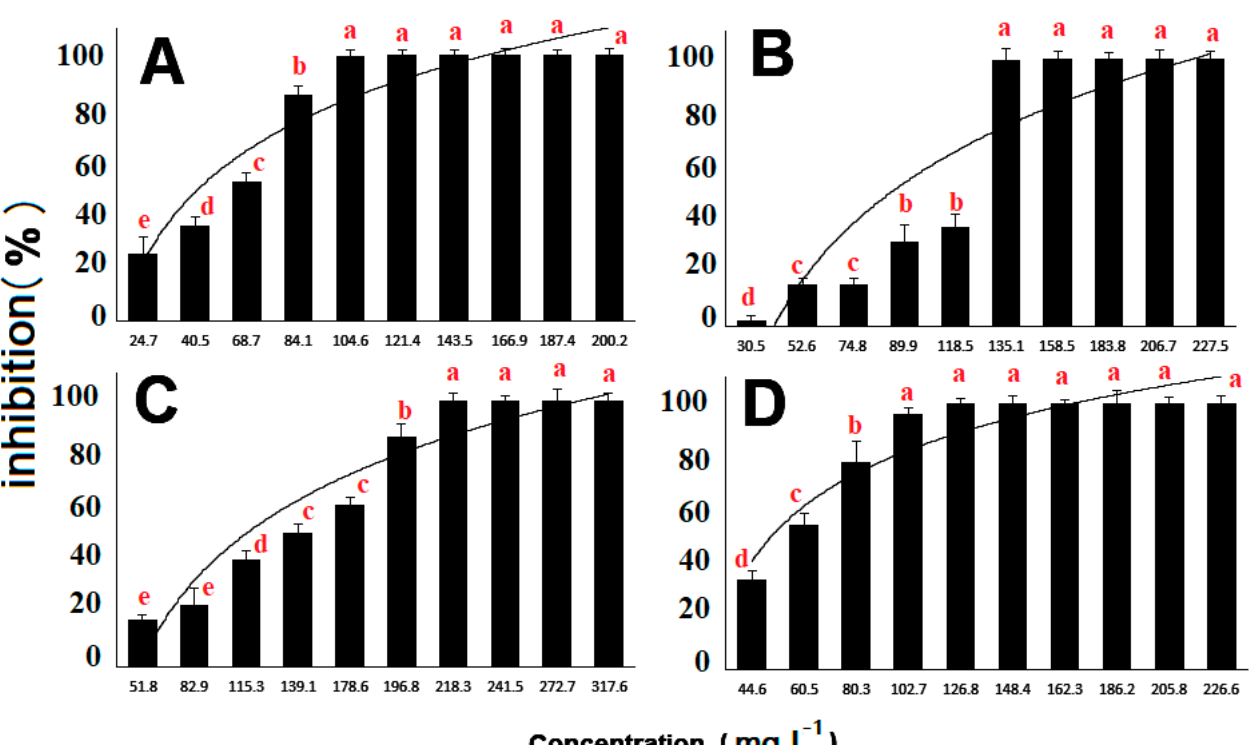
Figure 1. Dose–response curves obtained with the broth microdilución method using ZlEO ( A ) 2- undecanone ( B ), 2-undecenal ( C ) and 2-dodecenal ( D ) and hyphal discs from F. temperatum . Resazurin was used as an indicator of cell viability. Different letters indicate means (n = 25) with statistically significant differences by ANOVA-Tukey test ( p < 0.05).